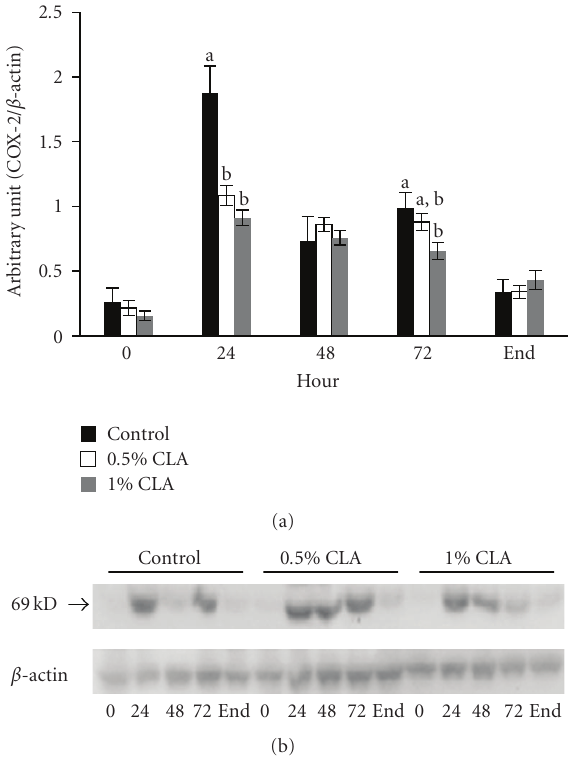
Figure 5: COX-2 protein expression in cutaneous wounds of mice fed diets containing 0 (control), 0.5%, or 1% CLA for 2 weeks. (a) Quantified COX-2 protein expression levels determined by densitometry. Values are mean ± SEM; N = 4 to 6 in each group. Means at a time with a di ff erent letter are significantly di ff erent, P < . 05. (b) 0; 0hr, 24; 24hr, 48; 48 hr, 72; 72 hr after wounding, end (wound is completely closed).